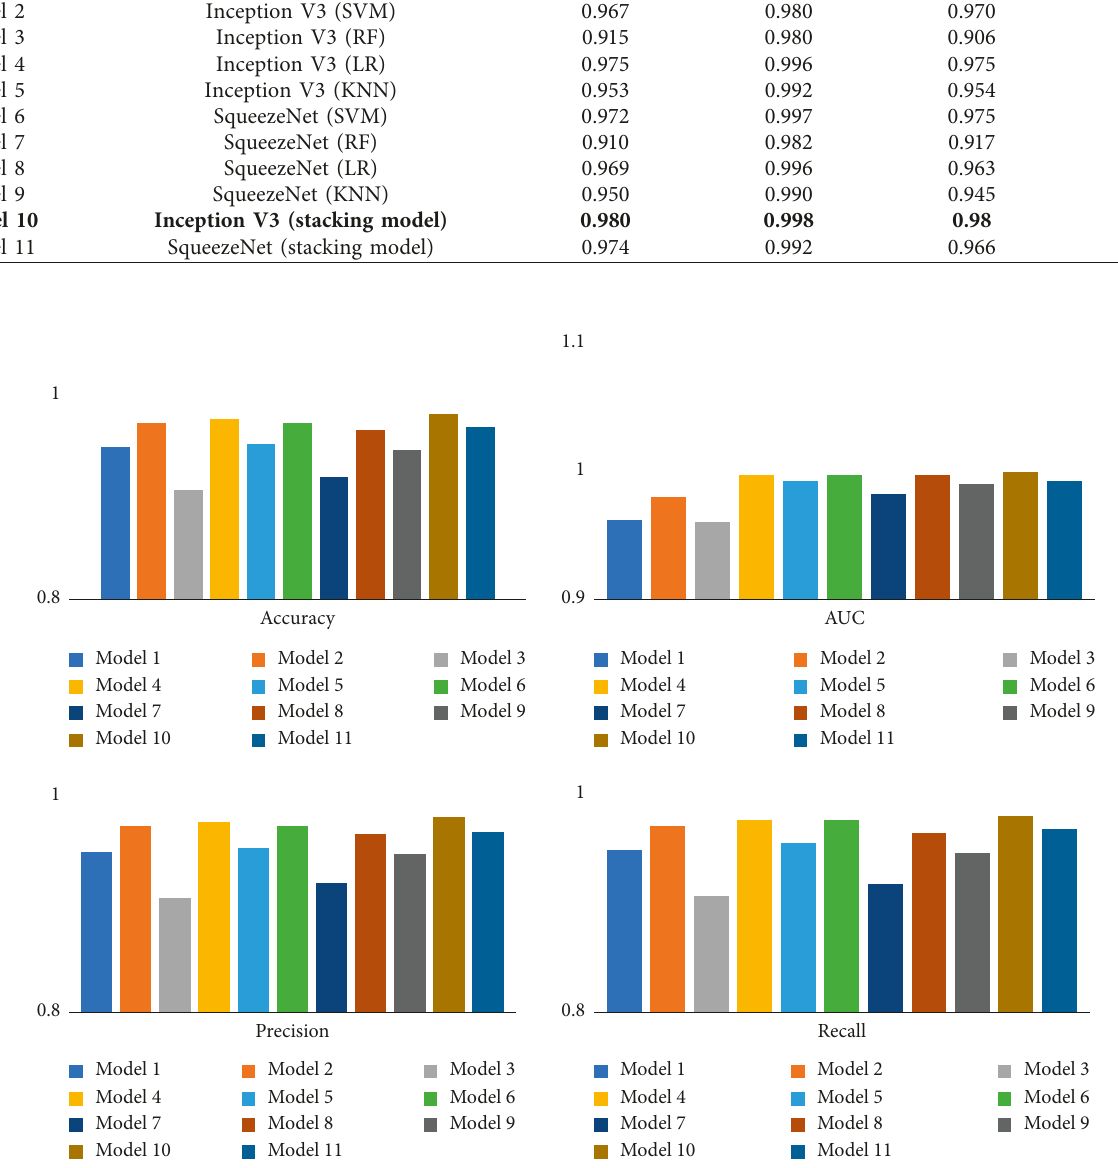
Figure 9: Comparison measures to determine the robustness of the models.